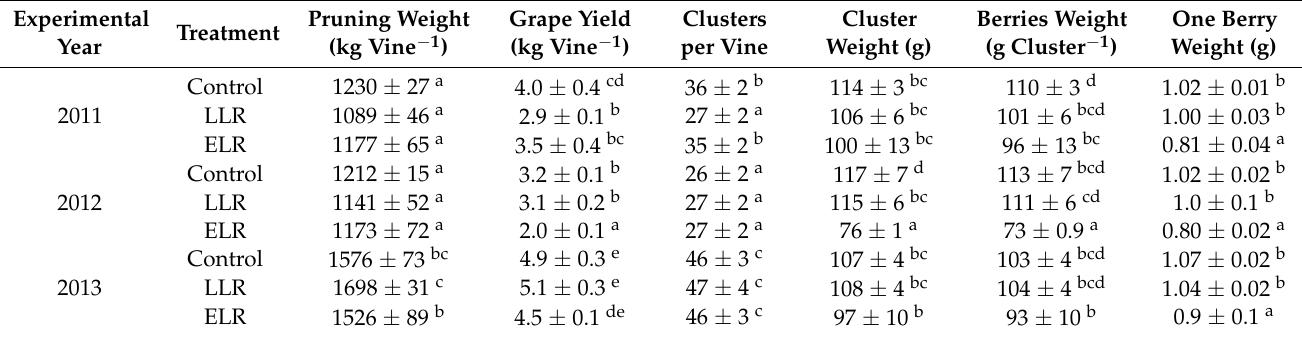
Table 2. Effects of leaf removal time and experimental year on the vegetative growth and yield components of Cabernet Sauvignon. LLR, late leaf removal; ELR, early leaf removal. Data are means of three replicates ± sd. Different letters in a column denote significant differences among treatments according to Tukey’s test following a two-way ANOVA at α = 0.05.